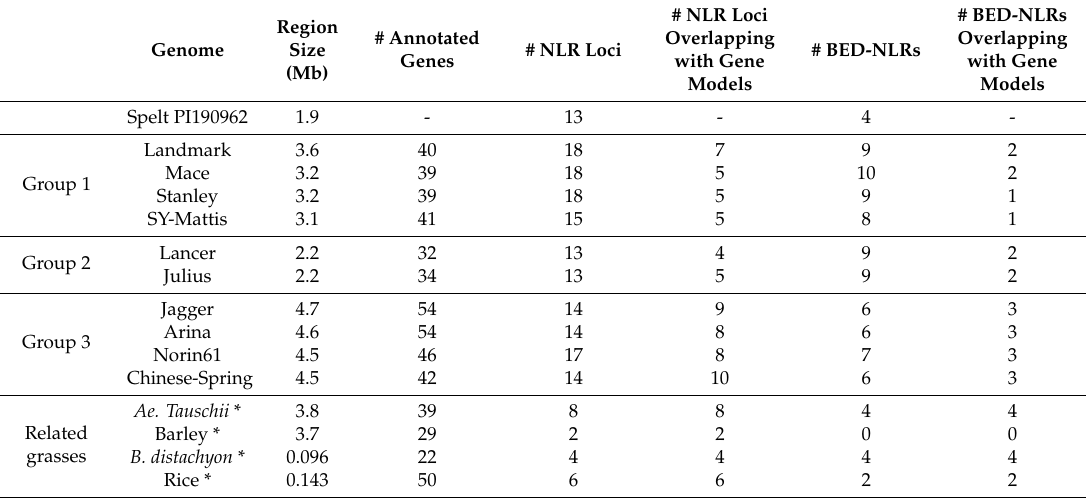
Table 3. Gene content with number of NLR and BED-NLR loci in Yr locus across chromosome scale assemblies of wheat genomes and related